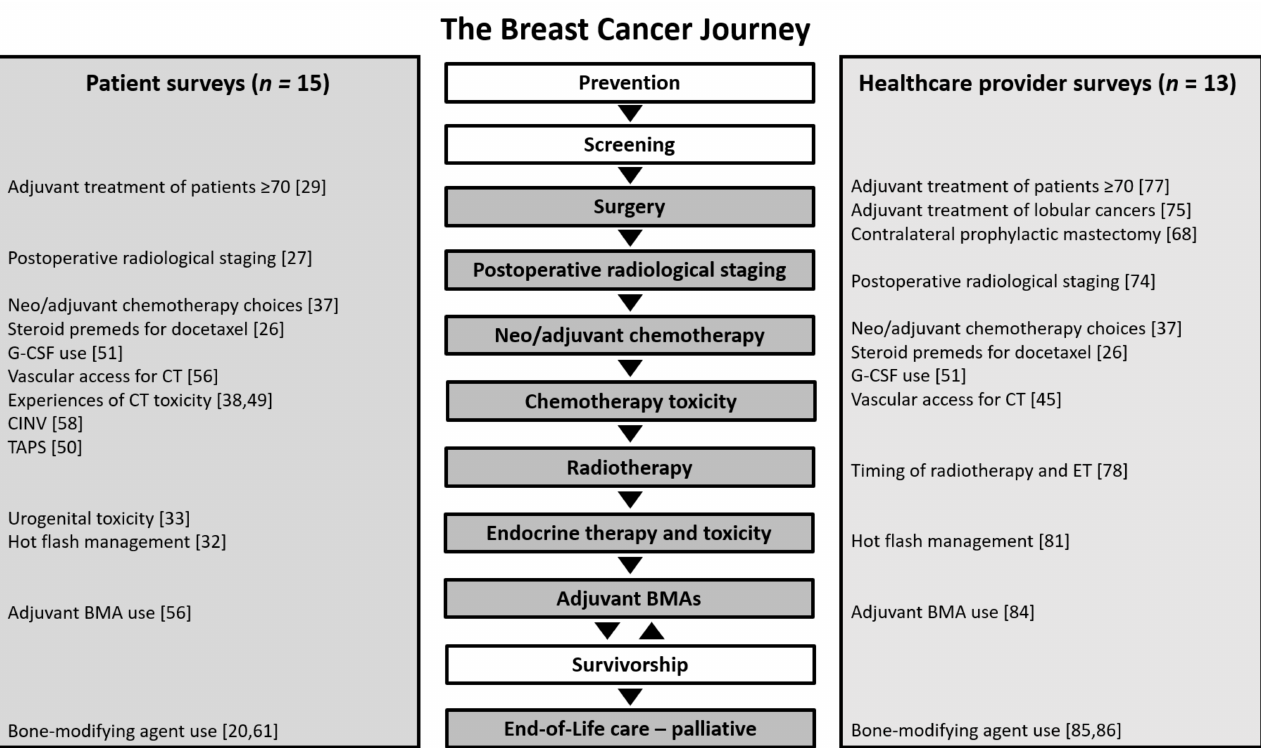
Figure 2. The breast cancer journey: where our surveys fit and where gaps exist. BMA = bone-modifying agent, CINV = chemotherapy-induced nausea and vomiting, CT = chemotherapy, ET = endocrine therapy, G-CSF = granulocyte colony stimulating factor, TAPS = taxane-associated pain